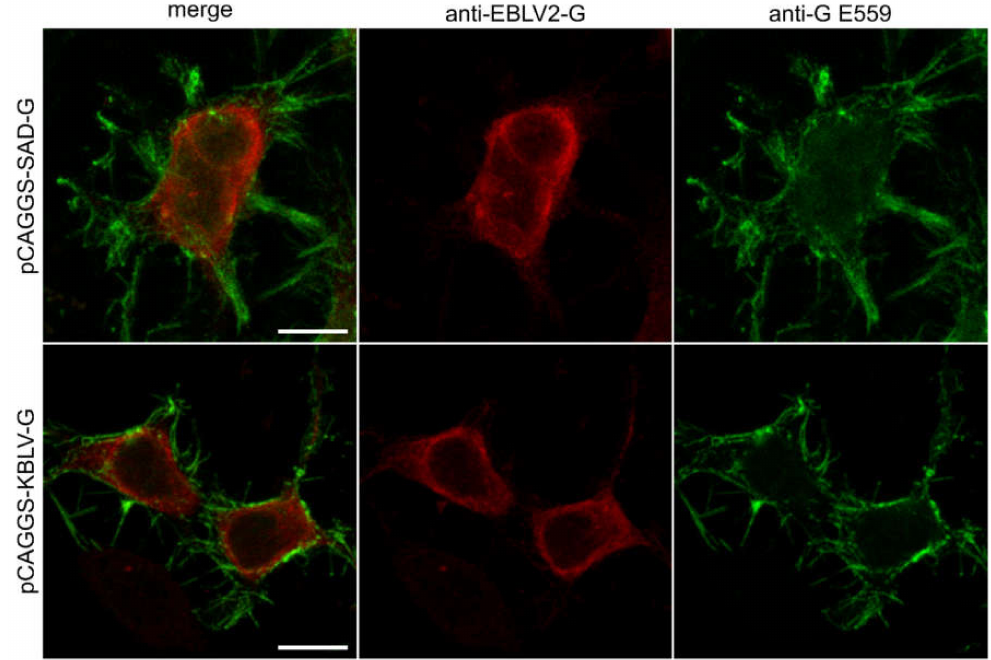
Figure 2. Distribution of KBLV G and RABV G protein in plasmid transfected cells: intracellular G-protein (red, stained with a rabbit-anti—EBLV-2 G polyclonal serum) and extracellular G-protein (green, stained with E559). Notably, E559 is a rabies virus-neutralizing monoclonal antibody [44] recognizing the conformational epitope of fully matured G-protein. The scale bar is 10 µ m in